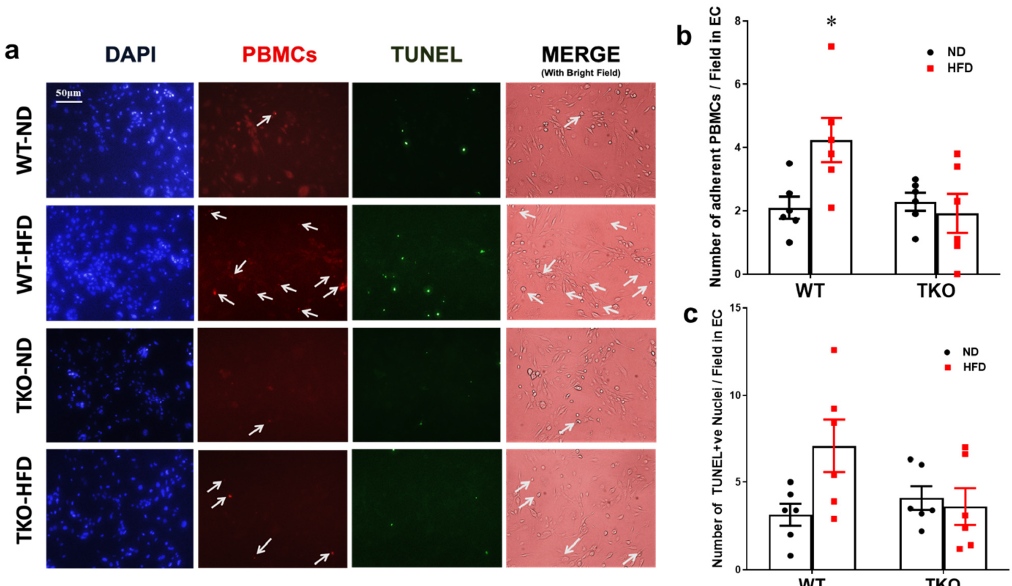
Figure 7. Deletion of TXNIP in leukocytes prevents leukostasis and REC death. ( a ) Representative images and ( b ) quantification of the number of adherent PBMCs (indicated by white arrows) to cultured mouse